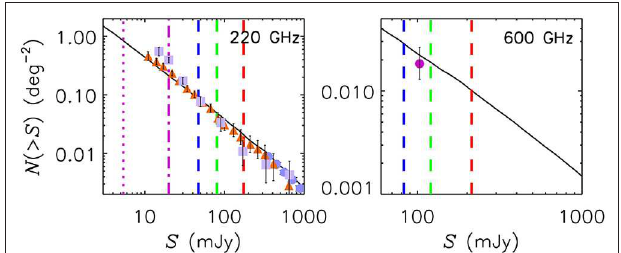
FIGURE 9 | Integral number counts of radio sources at 220 and 600 GHz. The vertical dashed lines show the 5 σ confusion limits for a space-borne experiment with a 1m, 1.5m, and a 2m telescope (from right to left) operating at the diffraction limit. The dot-dashed and dotted vertical lines on the left panel show the completeness limit of the SPT survey and the 5 σ confusion limit for the SPT telescope, respectively. The data points on the left panel are from Mocanu et al. (2013, SPT, orange triangles), Marsden et al. (2014, ACT, lavender squares), Planck Collaboration XIII (2011, light blue circles); the data point on the right panel is from Bonato et al. (2019b) and is based on Herschel survey data. The solid black lines are predictions of the Tucci et al. (2011)